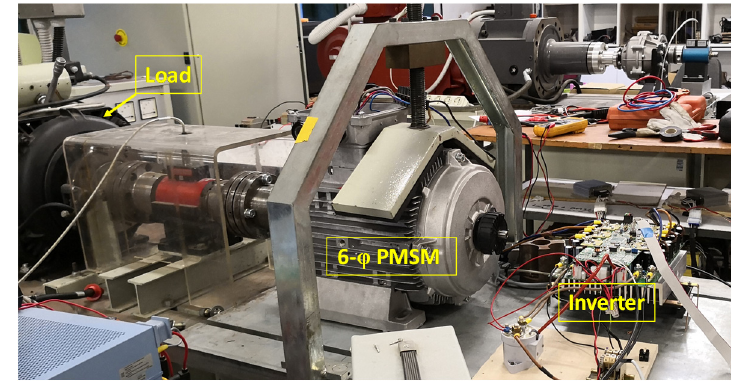
Figure 6. View of the experimental setup.